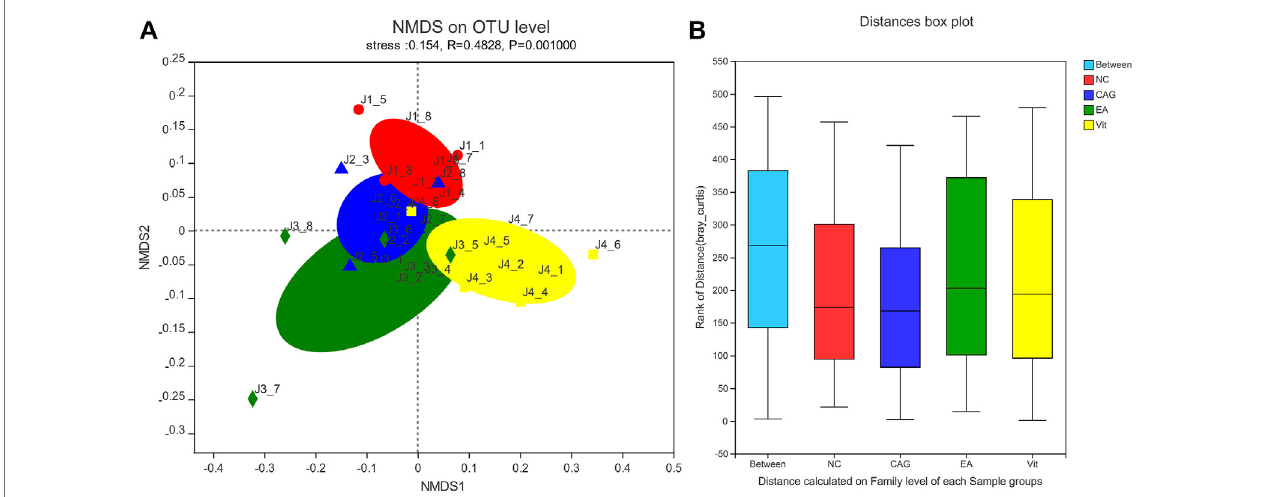
FIGURE5| NMDSscatterplotandbox plotofintergroupdistances. (A) NMDS scatterplot; each groupofsamplesisrepresented bydifferentcolorsand shapesof dots;thecloserthedotsare,themoresimilarthesamplesare. (B) Boxplotofdistancebetweengroups;the “ between ” boxesrepresentthedifferencesbetweengroups, and the others represent the differences within the respective